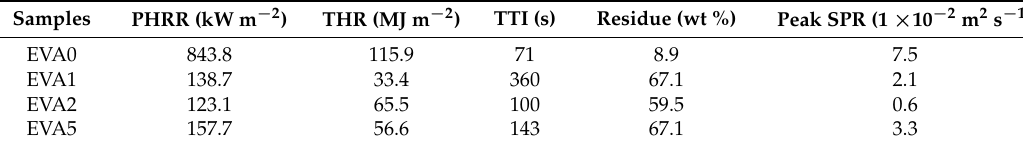
Figure 4. HRR ( a ), THR ( b ), SPR ( c ), and ML ( d ) curves of neat EVA and EVA composites at a flux of 35 kW m − 2 . Table 5. CC data of EVA and EVA composites at a flux of 35 kW m − 2